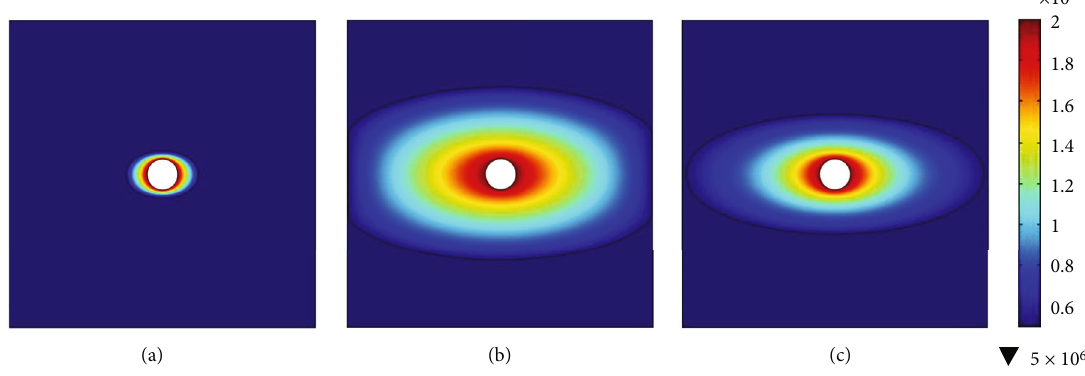
Figure 4: Pore pressure distribution during water and gas permeation: (a) water, (b) nitrogen, and (c) CO